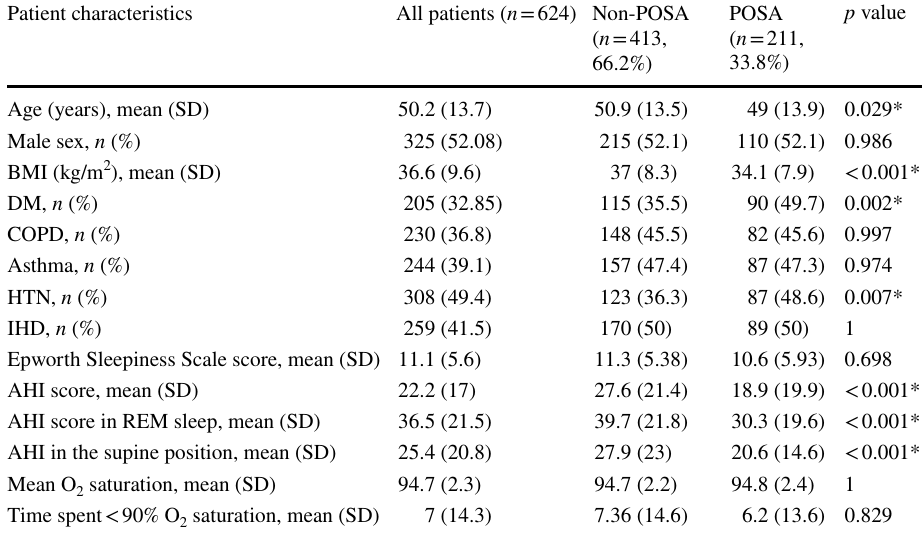
Table 5 General characteristics of patients classified according to POSA Definition